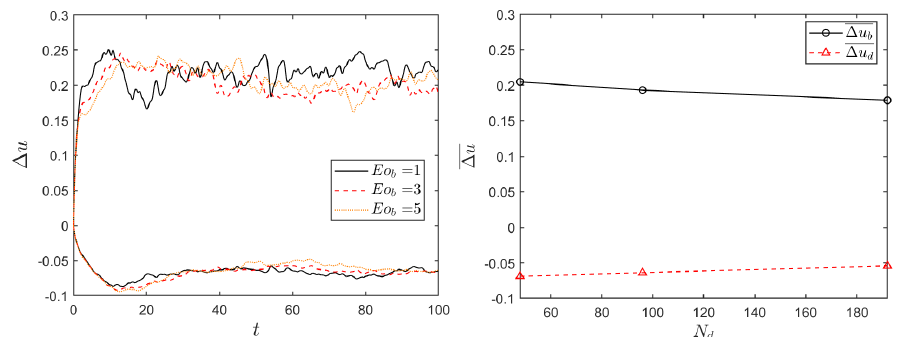
Figure 9. Slip velocity for the bubbles and the drops. Left : The slip velocity versus time for 96 drops and Eo b = 1.0, 3.0 and 5.0. Right : The time-averaged slip velocity for Eo b = 3.0 versus the number of drops N b